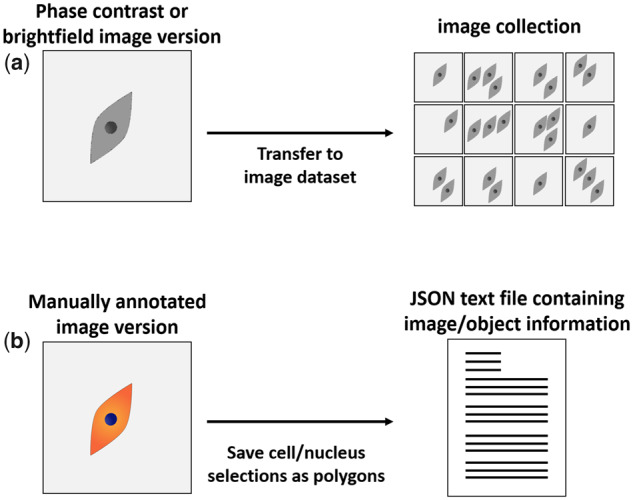
Dataset compilation. (a) Grayscale (PhC and BF) image versions were collected in a large-scale image collection. (b) Manual annotations (cell and nucleus segmentations) were transformed into polygons and saved in a JSON file. The compiled text file included information about images (ID, size and name) and objects (ID, class and polygon). All text information is referred to the grayscale image versions produced in (a)